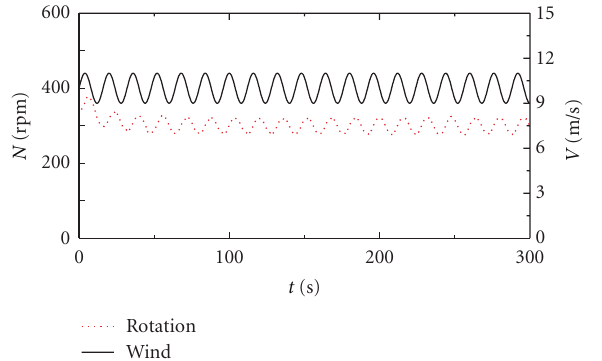
Figure 22: Time profile of rotational speed of pulsating wind in the case where V 0 = 10m/s, T = 16 s, and I = 5kgm 2 .